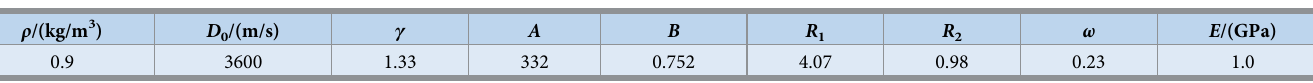
Table 2. Explosives equation of state